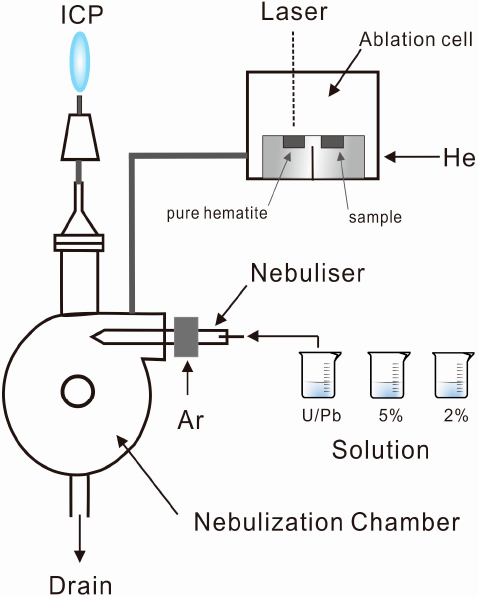
Figure 1. Schematic of the sample introduction system displaying the laser ‑ ablation inductively ‑ coupled plasma ‑ mass spectrometry (LA ‑ ICP ‑ MS) system connected to the U–Pb solution and blank HNO 3 solutions.